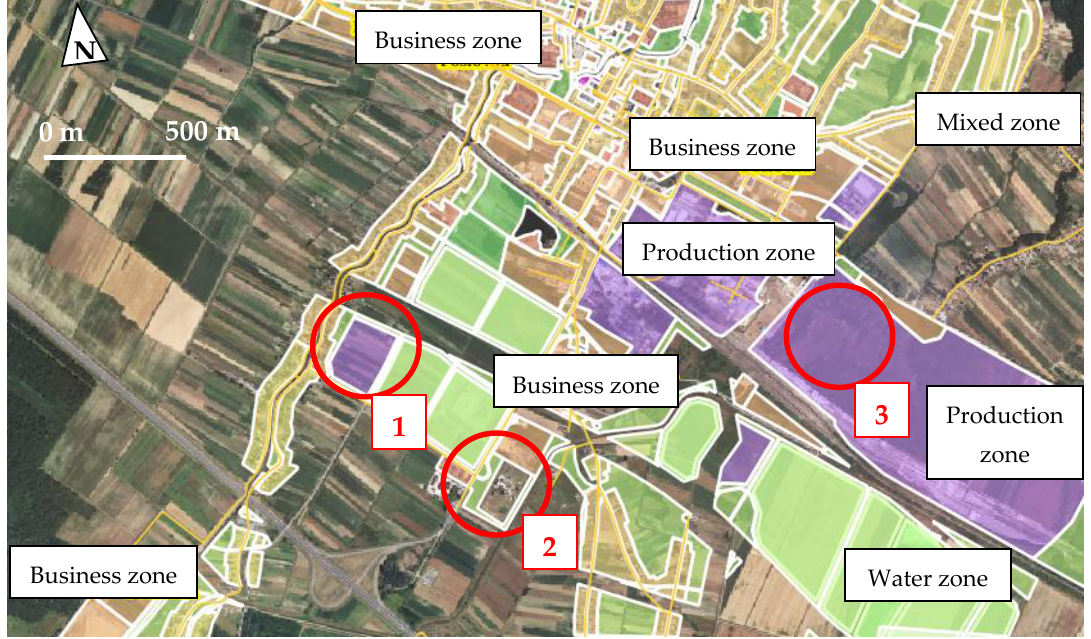
Figure 2. Town of Kutina—General Urban Plan and potential locations.